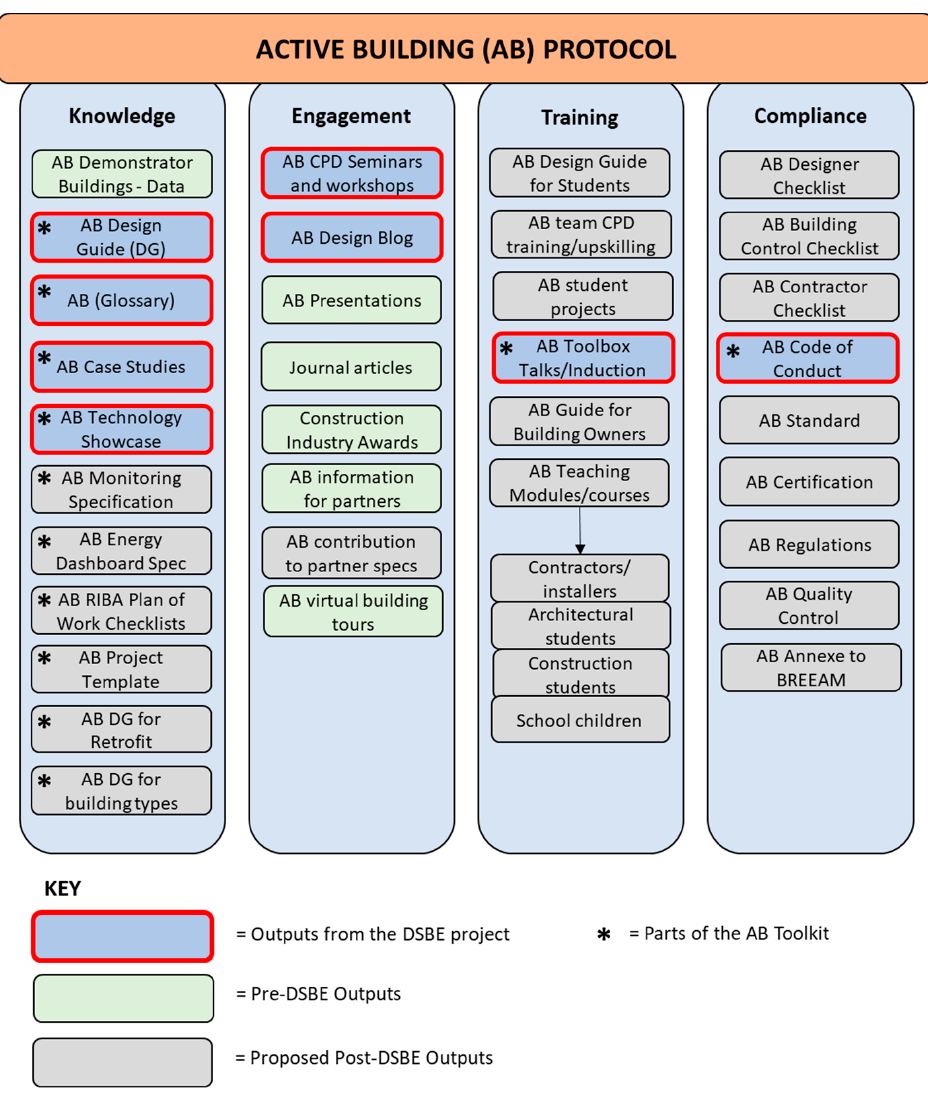
Figure 1. The AB Protocol developed by the author prior to commencing this research project [5].